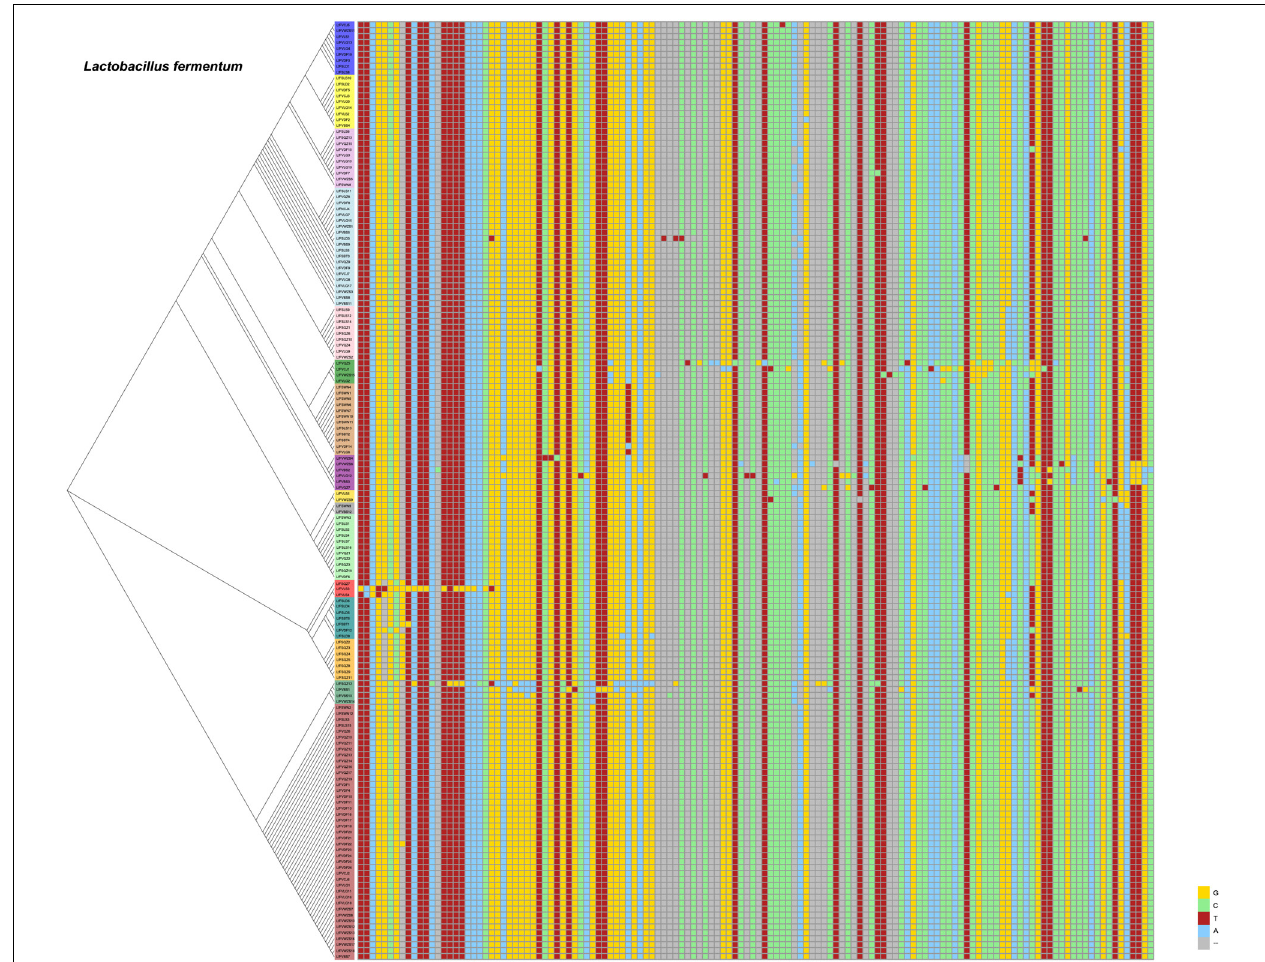
FIGURE 7 | SNPs of Lactobacillus fermentum in the samples.